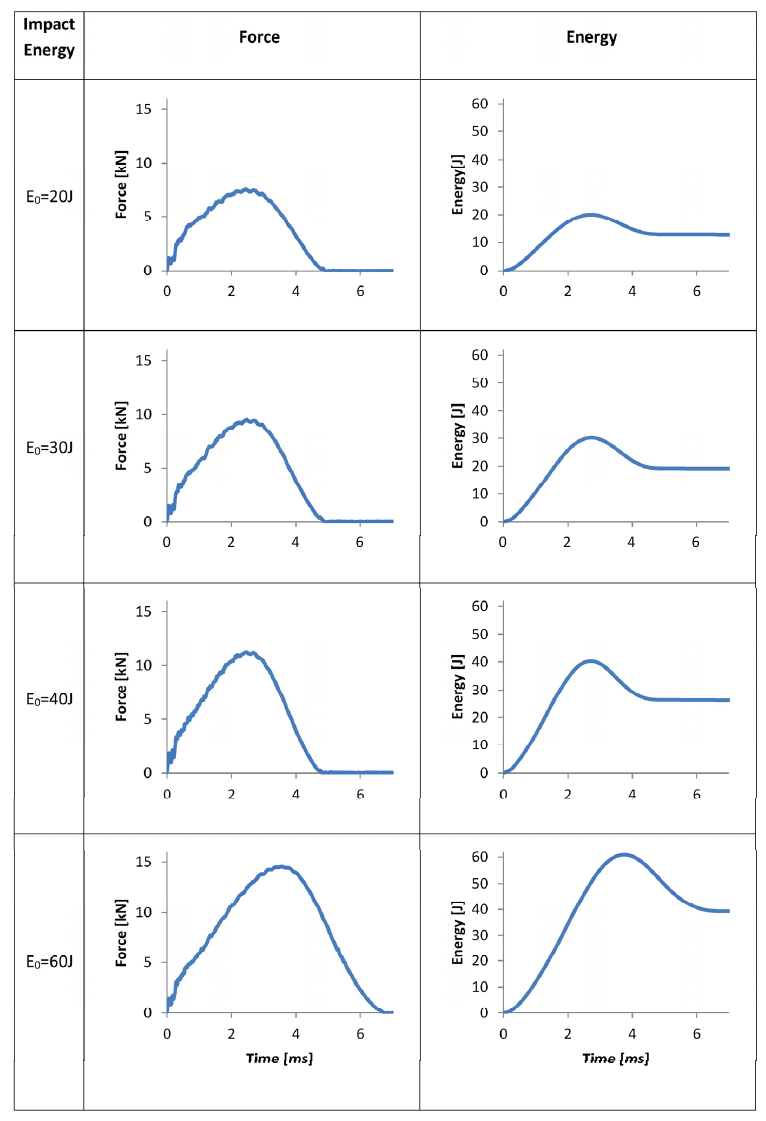
Figure 8. Impact force and transferred energy over time during impact tests of the FML at defined impact energies.